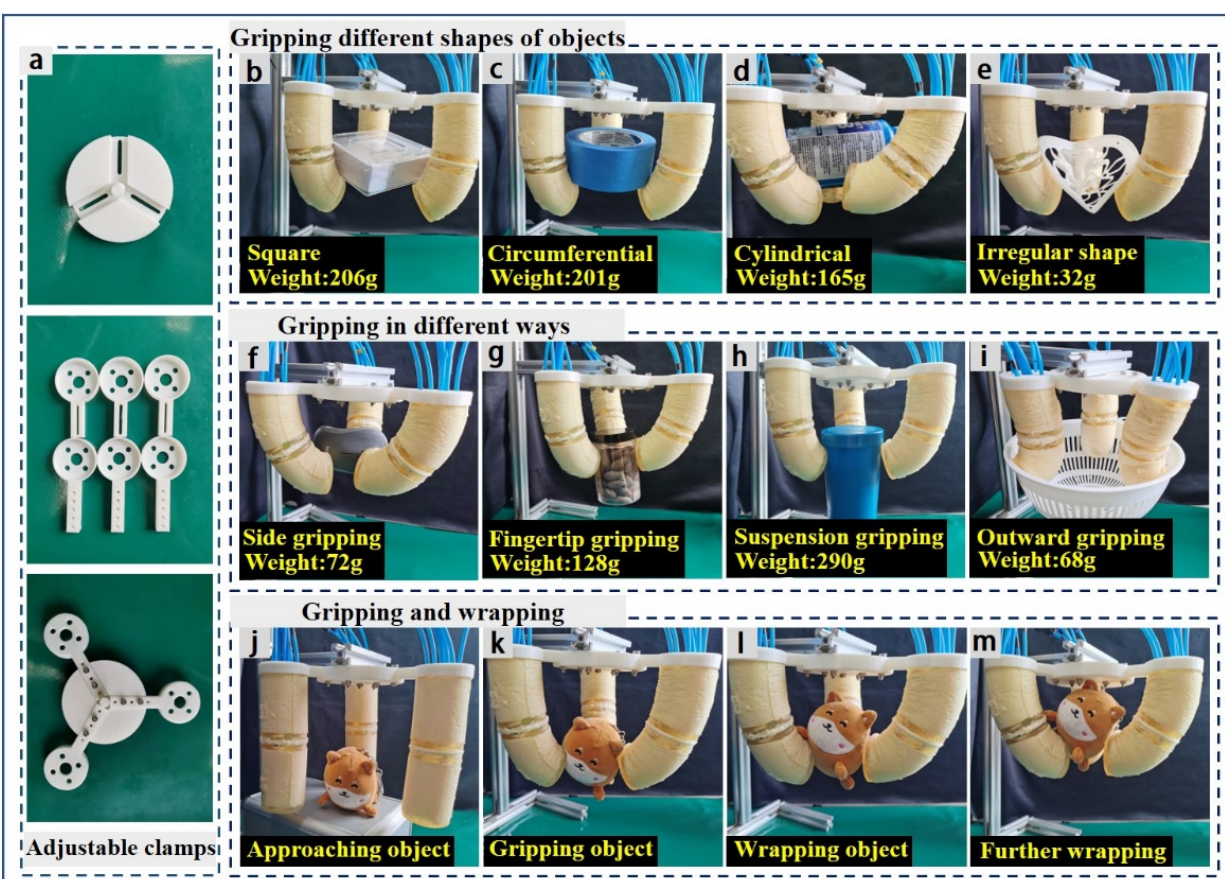
Figure 11. Soft robot used as a soft gripper: ( a ) adjustable clamps; ( b – e ) gripping square, circular, cylindrical, and irregularly shaped objects; ( f – i ) gripping objects by the side, fingertips, suspension, and outward pressure; ( j – m ) gripping and wrapping plush toys.